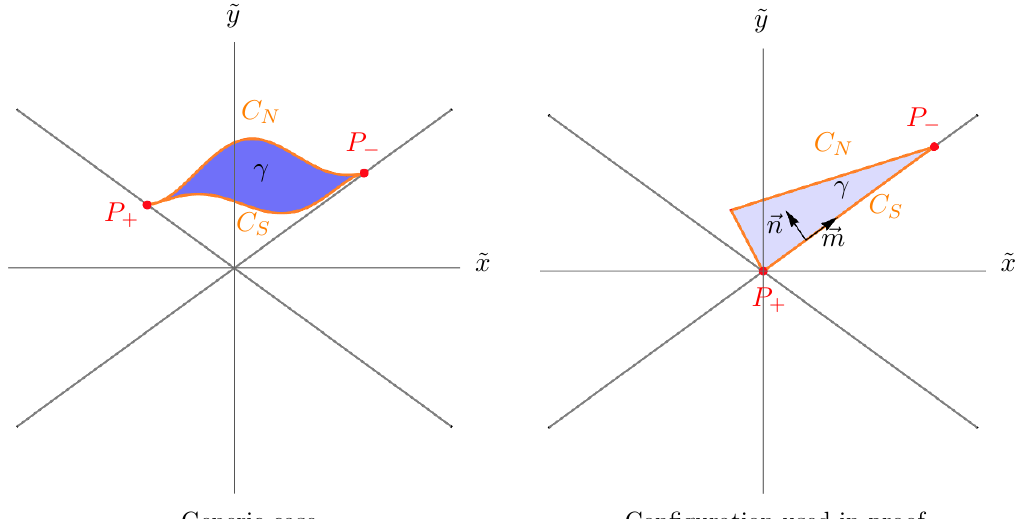
Figure 7 . Ryu-Takayanagi con(cid:12)guration in the Rindler bifurcation surface (~ x; ~ y ). This surface intersects the light sheafs (cid:13) + and (cid:13) (cid:0) at the points P + and P (cid:0) , which are restricted to lie on the lines (6.36) (in gray). The light sheafs (cid:13) N and (cid:13) S intersect the bifurcation surface at the curves C N and C S (in orange). These light sheafs are represented in (cid:12)gure